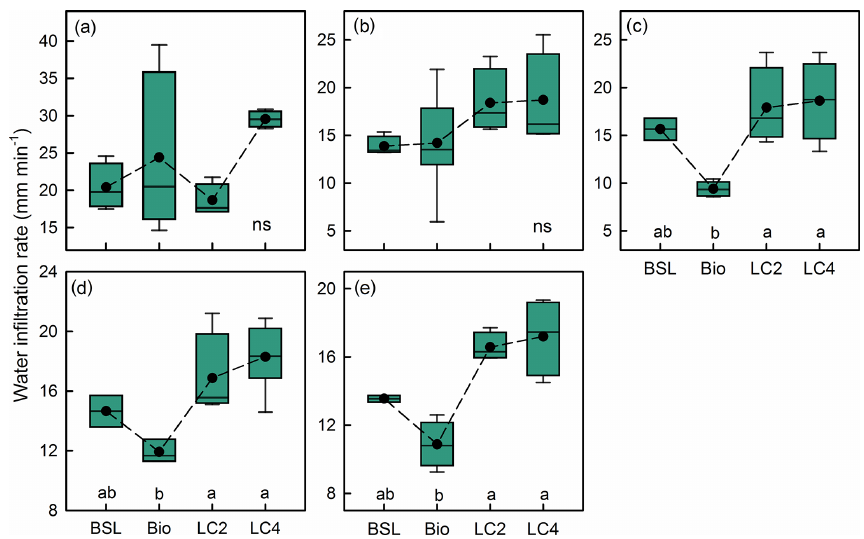
Figure 4. Water infiltration rates (M ± SE) of different water volumes ( a – 500, b – 1000, c – 1500, d – 2000, and e – 2500mL) among bare sandy land and crust types. Note: ns, no significant difference, BSL, bare sandy land, Bio, moss crust; LC2, litter crust for 2 years; LC4, litter crust for 4 years. Dashed lines represent the average values. Different lowercase letters indicate significant differences among the various crust plots at the level of p< 0 .